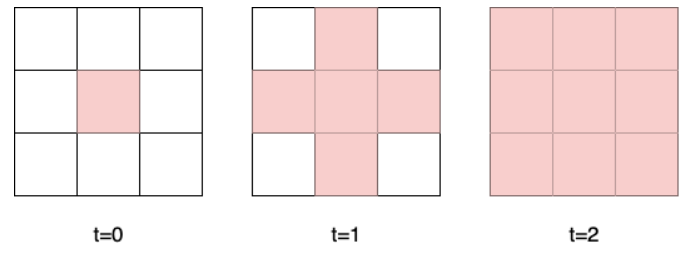
Figure 3. CA evolution using Von Neumann